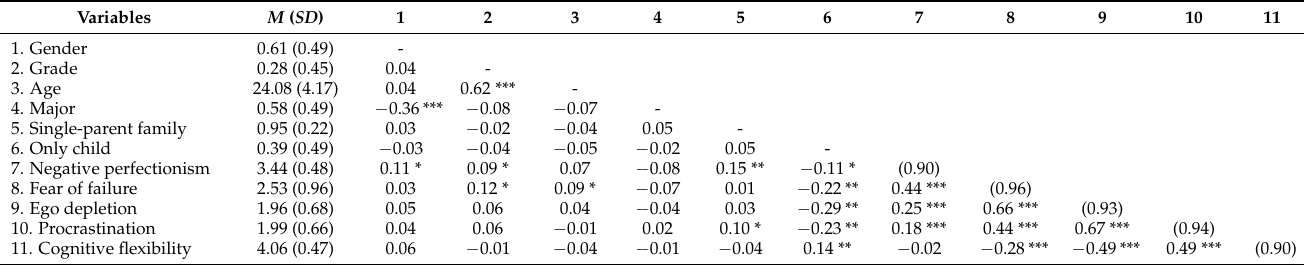
Table 2. Mean values, standard deviations, and correlation coefficients for all variables.